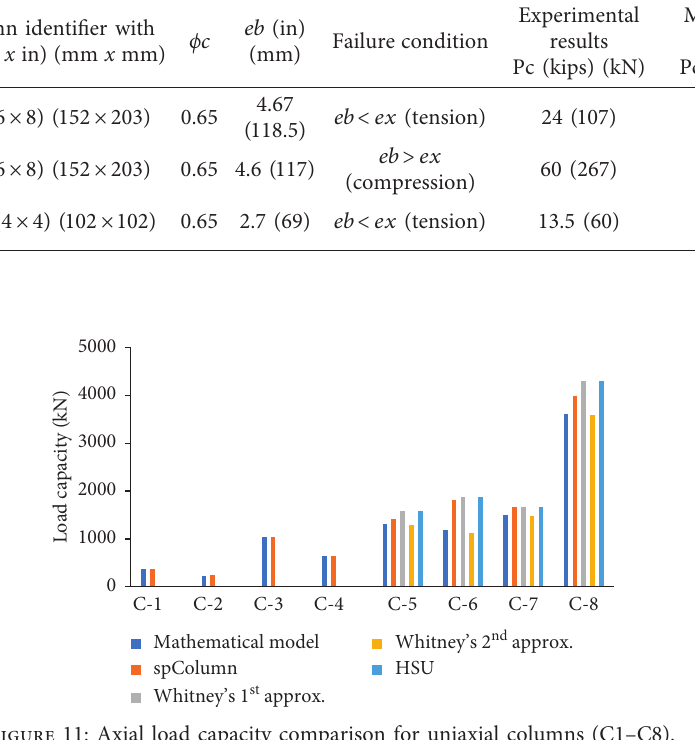
Table 7: Validation of experimental data [22].